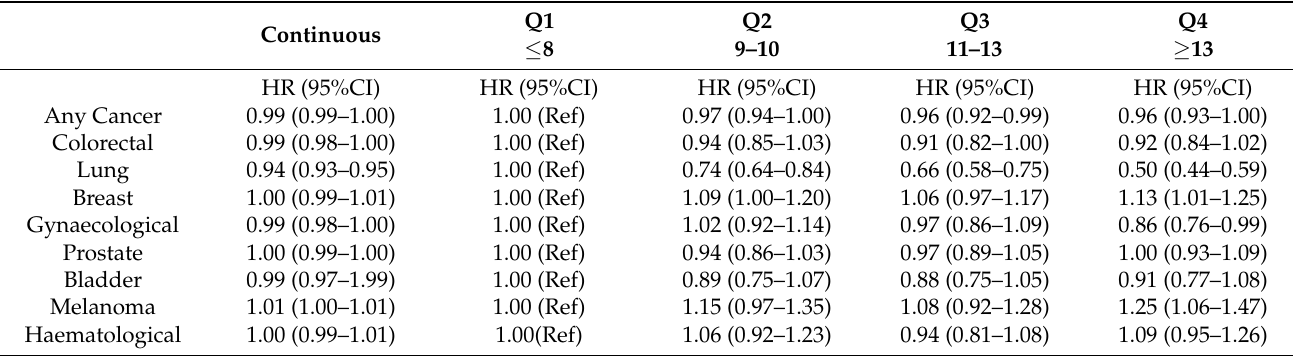
Table 3. Hazard ratios (HR) and 95% confidence intervals (CI) for continuous and quartiles of serum total bilirubin (STB), by overall cancer risk and stratified by sex.